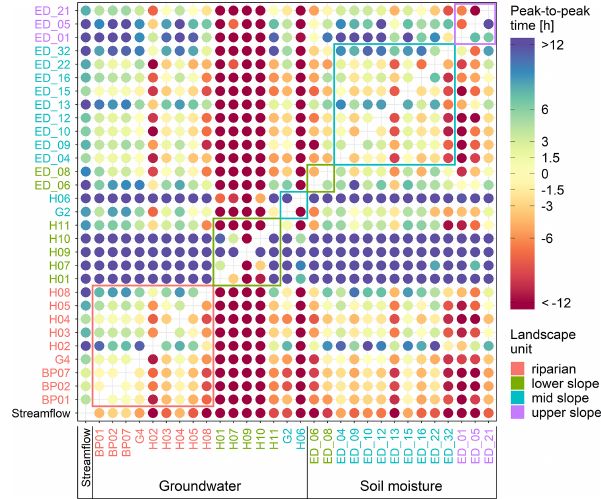
Figure 8. Median peak-to-peak time between streamflow at catch- ment outlet (streamflow), groundwater (BP ∗∗ , H ∗∗ , G ∗ ) and soil moisture (ED_ ∗∗ ). Time is positive if the row station peaks be- fore the column station and negative if the row station peaks after the column station. Circles’ colour corresponds to the value of the peak-to-peak time. The station names’ colour corresponds to their landscape unit. Coloured rectangles enclose values of stations in the same landscape